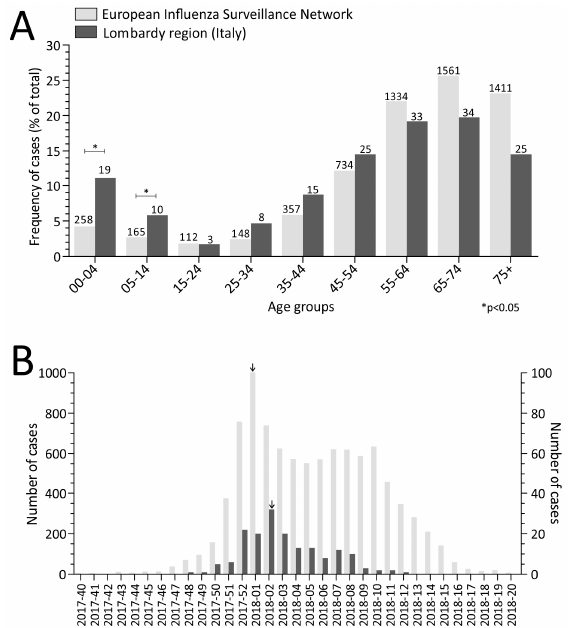
Figure 1. Laboratory-confirmed influenza in intensive care unit (ICU)-admitted cases by age group ( A ) and by week ( B ) observed in the framework of the European Influenza Surveillance Network (EISN) [12] and in Lombardy. Number of patients is reported on the top of each column. The peak of cases is reported with an arrow above the column.